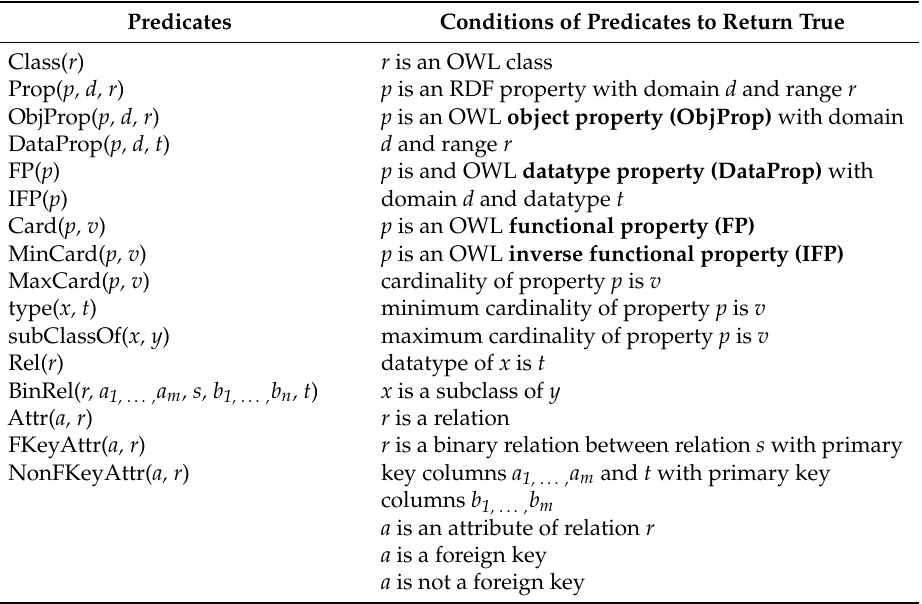
Table A1. List of predicates used in mapping